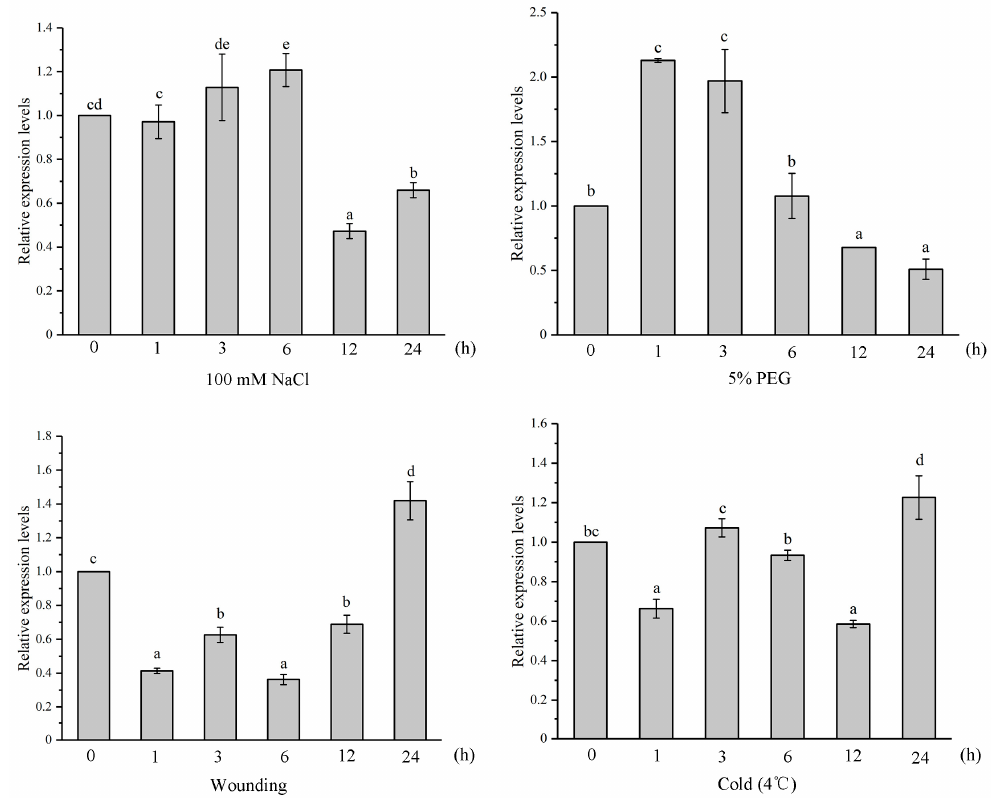
Figure 6. The expression patterns of IiYUCCA6-1 under different stress treatments. Different lowercase letters indicate significant differences for the relative expression at the p < 0.05 level.